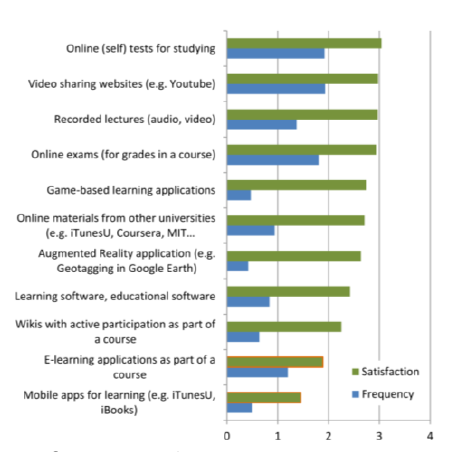
Figure 9. Means of students’ responses to the